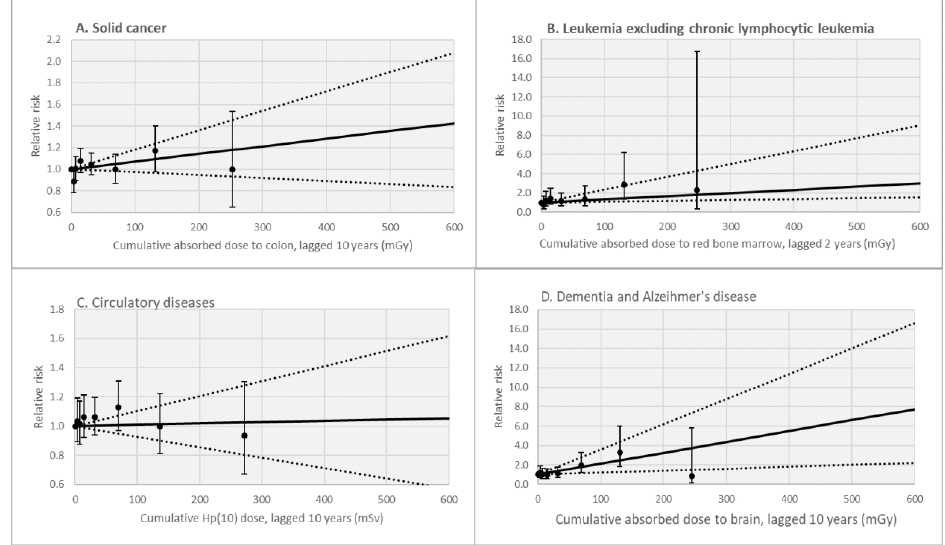
Figure 2. Relative risk of mortality due to solid cancer (panel A ), leukaemia excluding chronic lymphocytic leukaemia (panel B ), circulatory diseases (panel C ), and dementia and Alzheimer’s disease (panel D ) by categories of cumulative dose in milliGray (mGy) in male workers, SELTINE. Solid line: fitted linear dose–risk model (at attained age 65 years for panel B); dashed lines: 95% confidence interval; dark circles and associated vertical lines: point estimates of relative risks and associated 95% confidence interval.